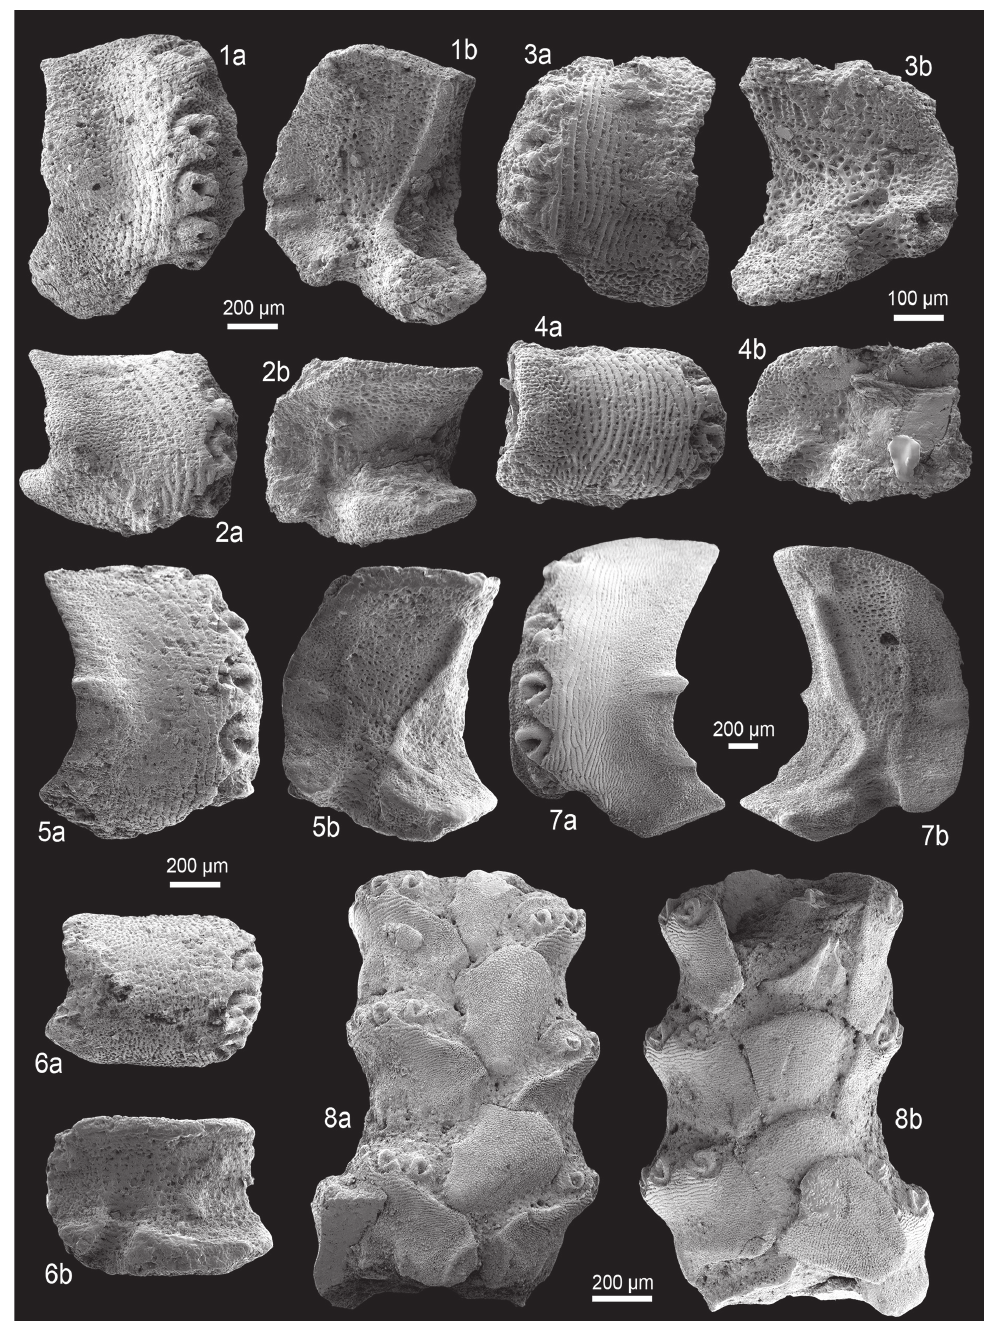
Fig. 27. Fossil lateral arm plates in external (a) and internal (b) views and articulated arm fragment of ophiacanthid brittle stars. 1-2. Dermocoma wrighti Hess, 1964 from the early Callovian (Middle Jurassic) of Liesberg, Switzerland. 1. NHMB M11218, proximal LAP. 2. NHMB M11219, distal LAP. 3-4. Dermocoma sp. 1 from the Callovian (Middle Jurassic) of Jumara, India. 3. GZG.INV.78687, proximal LAP. 4. GZG.INV.78688, distal LAP. 5-8. Dermocoma biformis (Hess, 1975) comb. nov. from the late Oxfordian (Late Jurassic) of Guldental, Switzerland (5-6) and Savigna, France (7-8). 5. NHMB M11220, proximal LAP. 6. NHMB M11221, distal LAP. 7. GZG.INV.78690, proximal LAP. 8. GZG. INV.78692, proximal arm fragment in ventral (a) and dorsal (b) views. One common scale bar for 1-2, 3-4, 5-6, 7 and 8